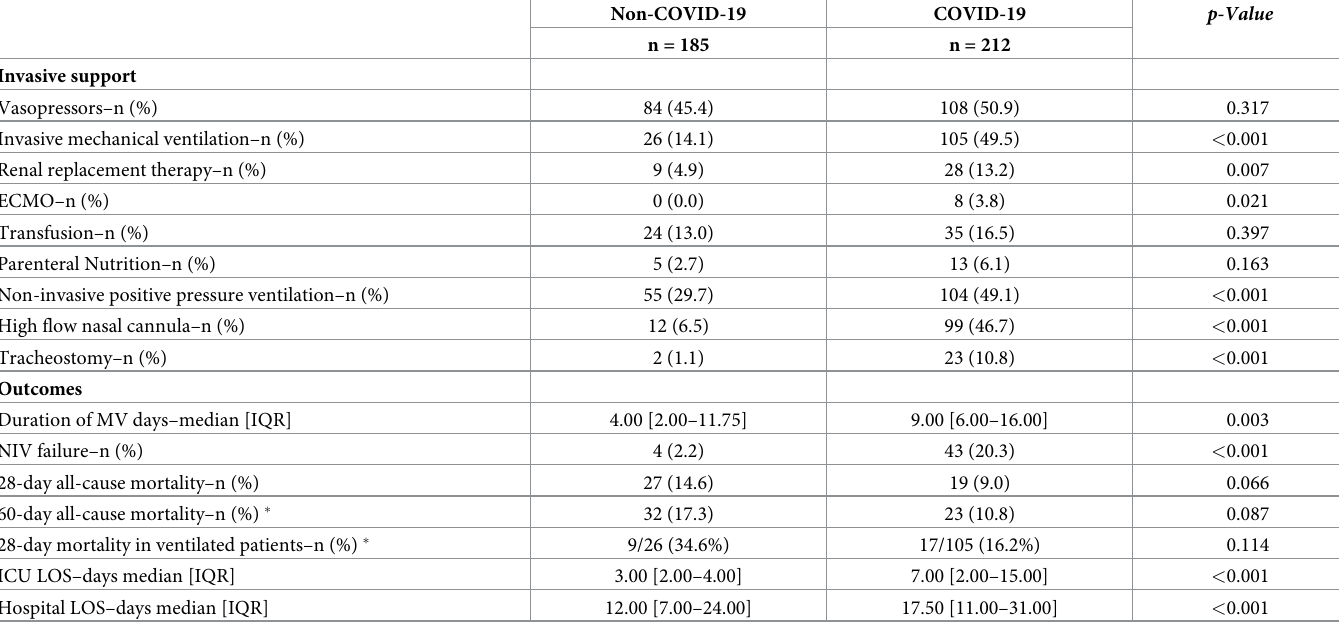
Table 2. Use of hospital resources and